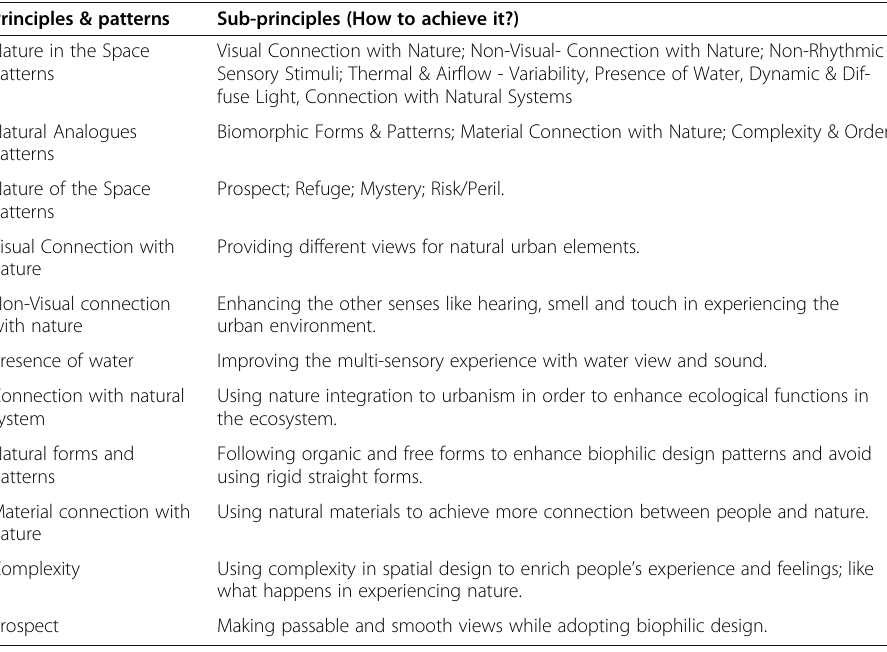
Table 2 Biophilic principles and patterns adopted from [28, 39, 40] Principles & patterns Sub-principles (How to achieve it?) Nature in the Space